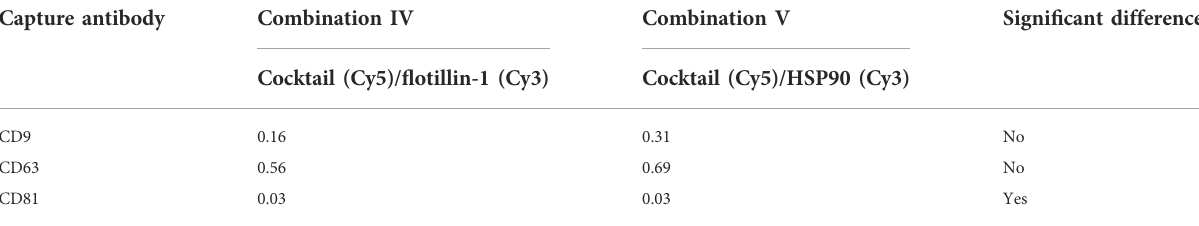
TABLE 3 p -values from the comparison of separately vs. simultaneously measured antibody compositions with Cy5- and Cy3-labeled molecules. Capture antibody Combination I Combination II Combination III Signi fi cant difference Flotillin-1 (Cy3) HSP90 (Cy3) Cocktail (Cy5) CD9 0.84 CD63 0.56 0.22 No CD81 0.84 0.84 No p -values were calculated using the Wilcoxon matched-pairs signed rank